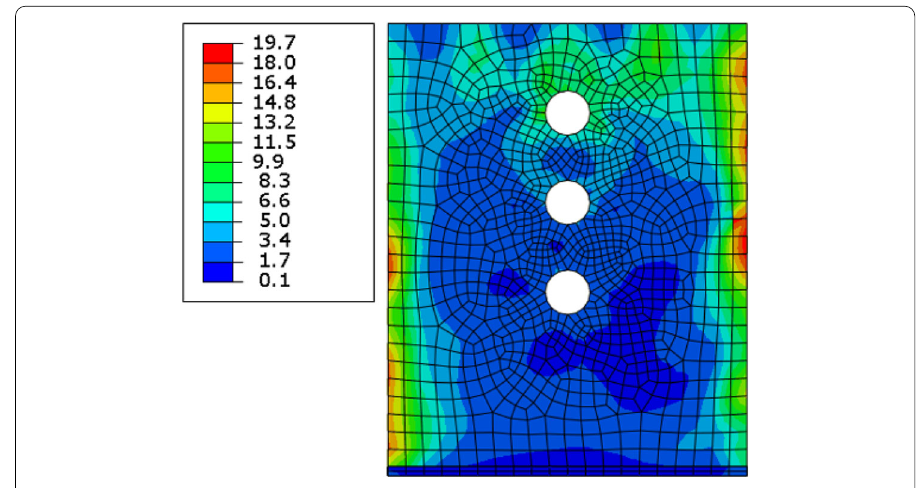
Fig. 13 Triple hole feature model in (MPa)